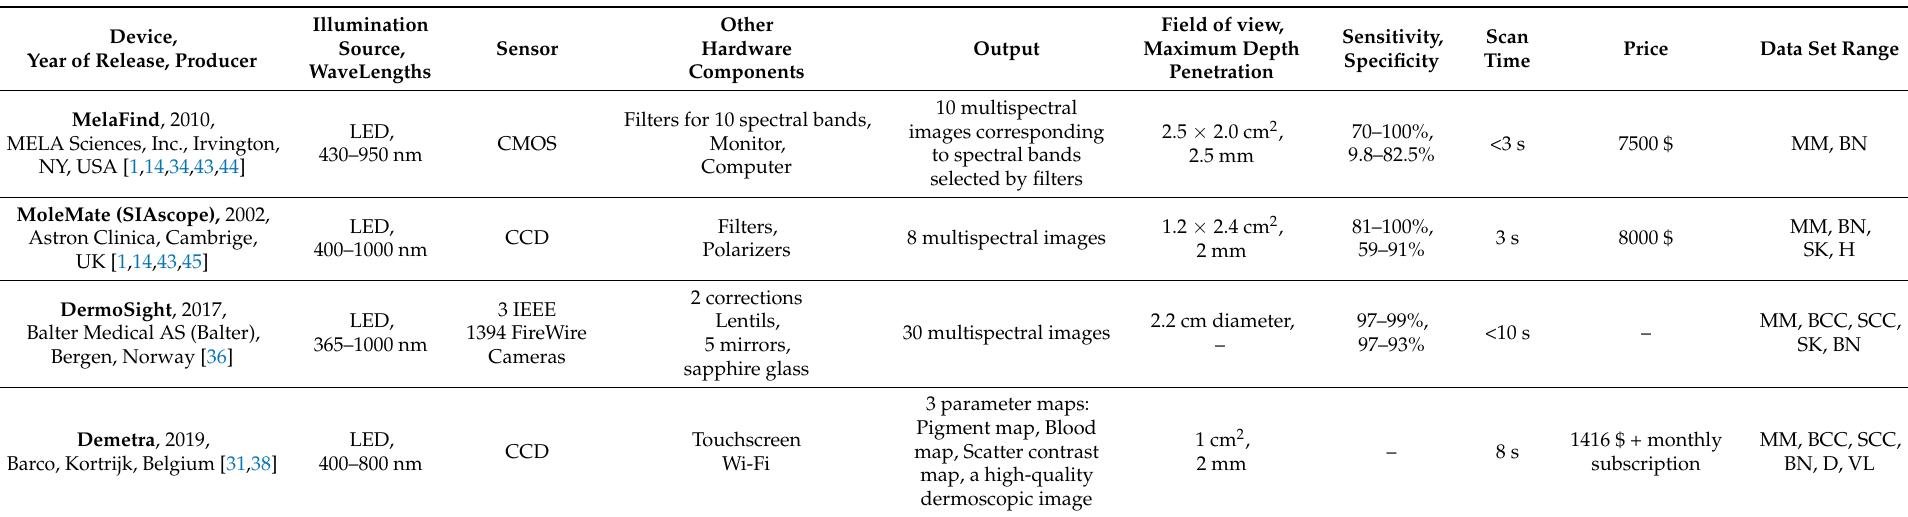
Table 4. Features of commercial MSI systems for